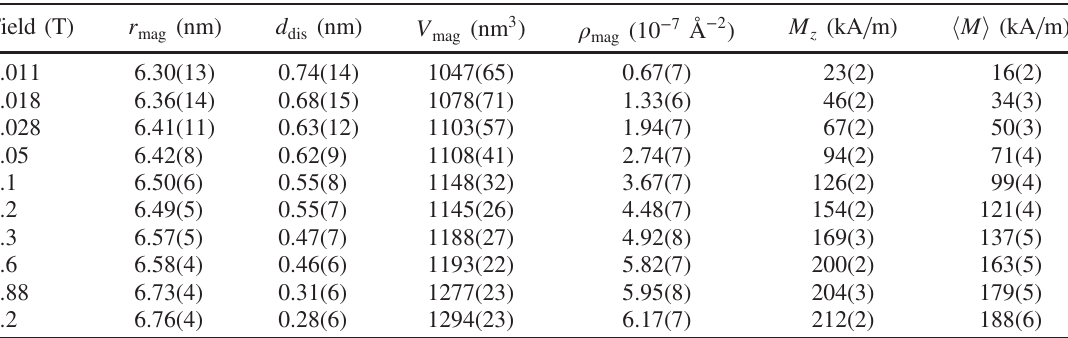
, and the magnetic scattering length density ρ dis and longitudinal magnetization M mag